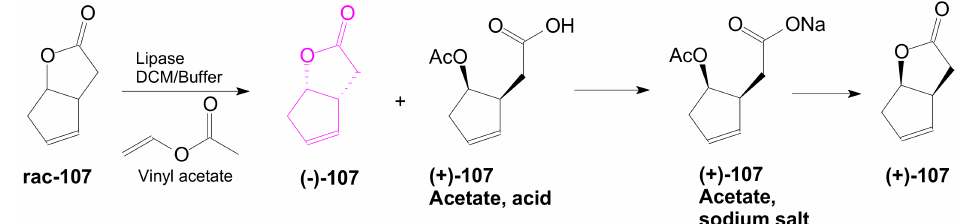
Scheme 43. Enzymatic resolution of the racemic γ -lactone 107 into optically active enantiomers ( − ) - 107 and (+) - 107 . The desired enantiomer ( − )-107 (in pink) remained pure; only the enantiomer (+)-107 of the racemic was acetylated to (+)-107 acetate as acid (in